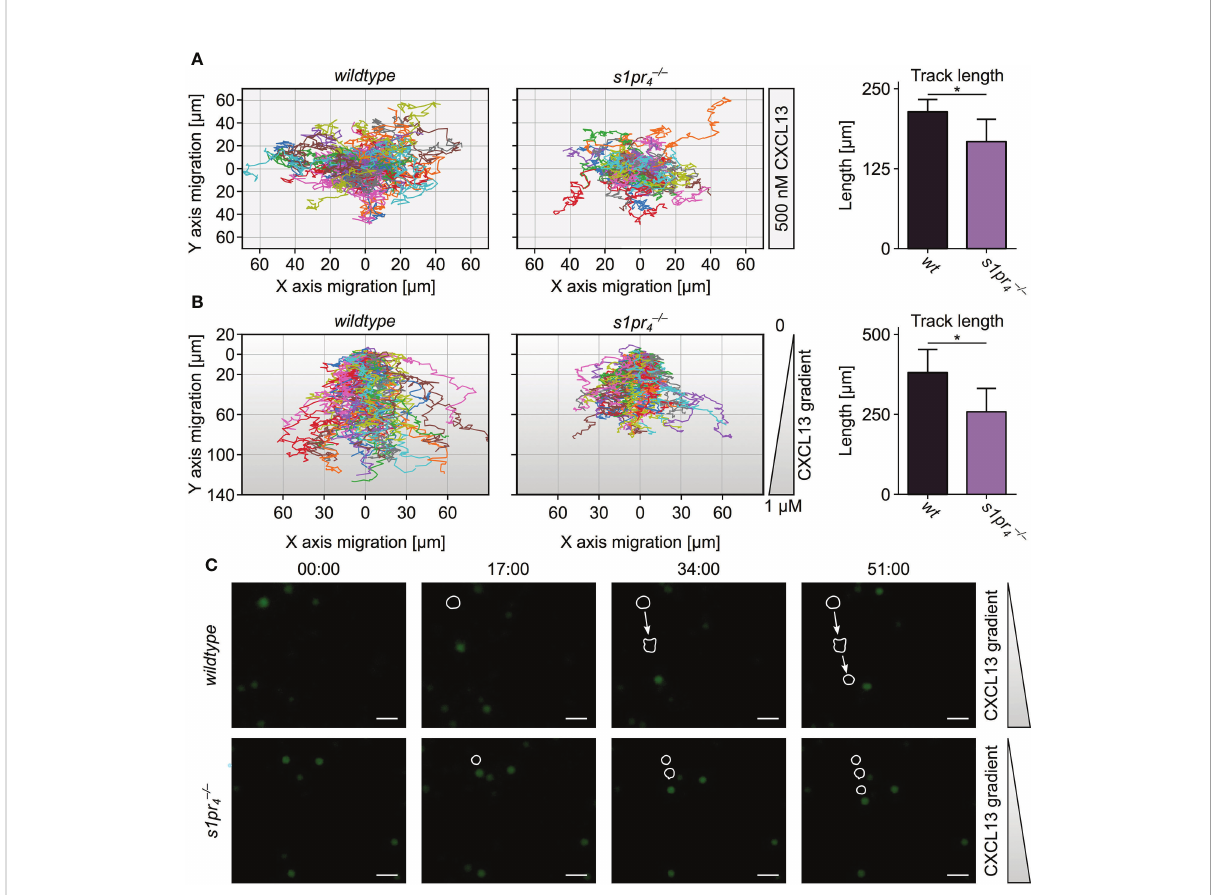
FIGURE 2 Ex vivo migration of splenic B cells in the presence of CXCL13. (A) Chemokinesis of CFSE-stained B cells in the presence of 500 nM CXCL13. (B) Chemotaxis of CFSE-stained B cells towards a CXCL13 gradient. Track length was quanti fi ed using TrackMate. Each color line represents the track of a speci fi c cell. Representative image sequences are shown with exemplary cell tracks marked. * p < 0.05. Values represent mean + standard deviation of n = 5 animals per condition. (C) Time-lapse images representing the migration of individual cells toward a CXCL13 gradient. White scale bars equal 50